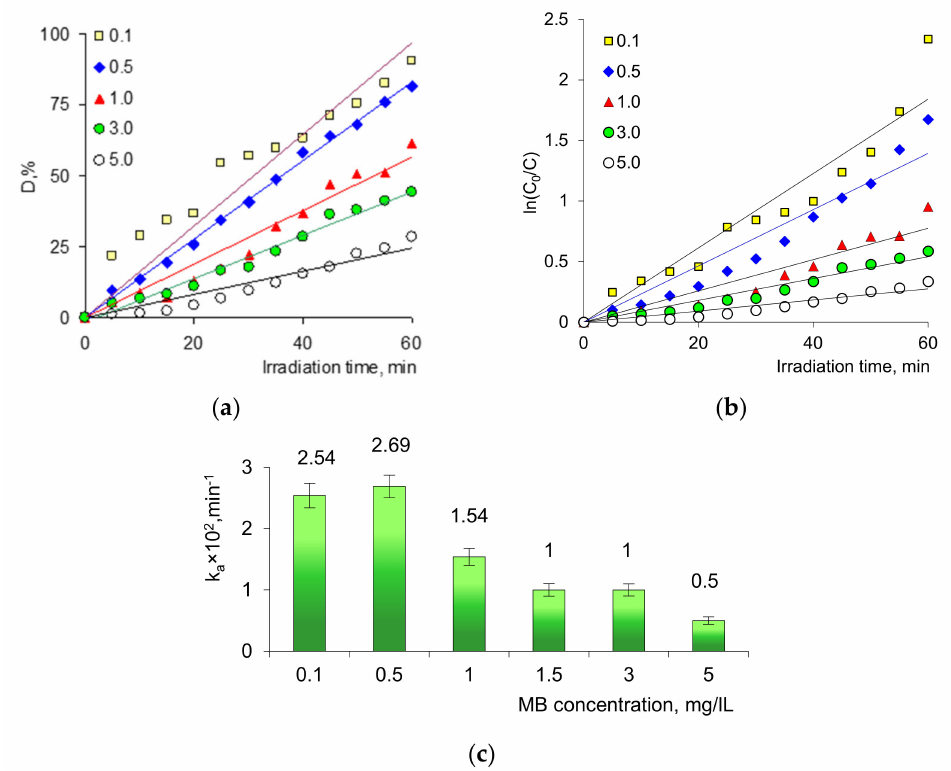
Figure 4. The change of degree of dye decomposition (D, %) achieved at various MB feed concentrations in the presence of Ag/PET composite ( a ), variation of natural logarithm of normalized concentration (ln(C 0 /C)) as a function of visible light irradiation time ( b ). and change of the apparent rate constant k a values at different MB feed concentrations ( c